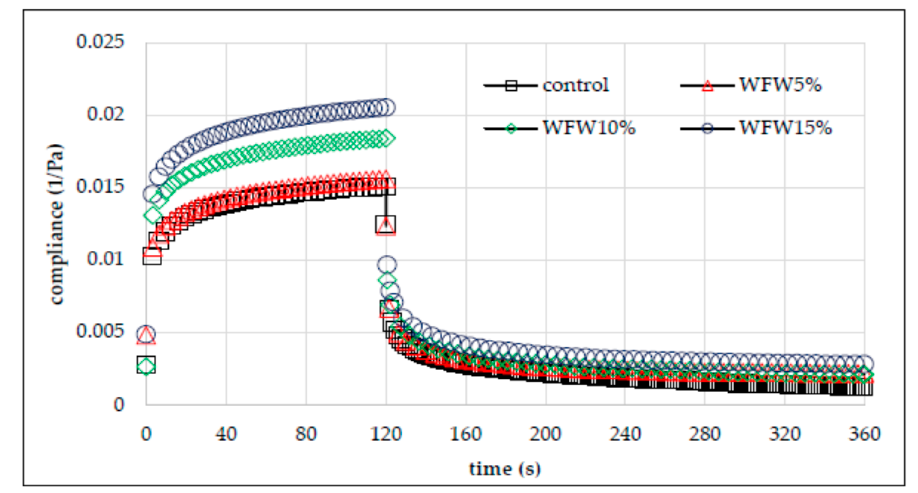
Figure 8. Creep and recovery curves of wheat flour gel and samples with walnuts addition.